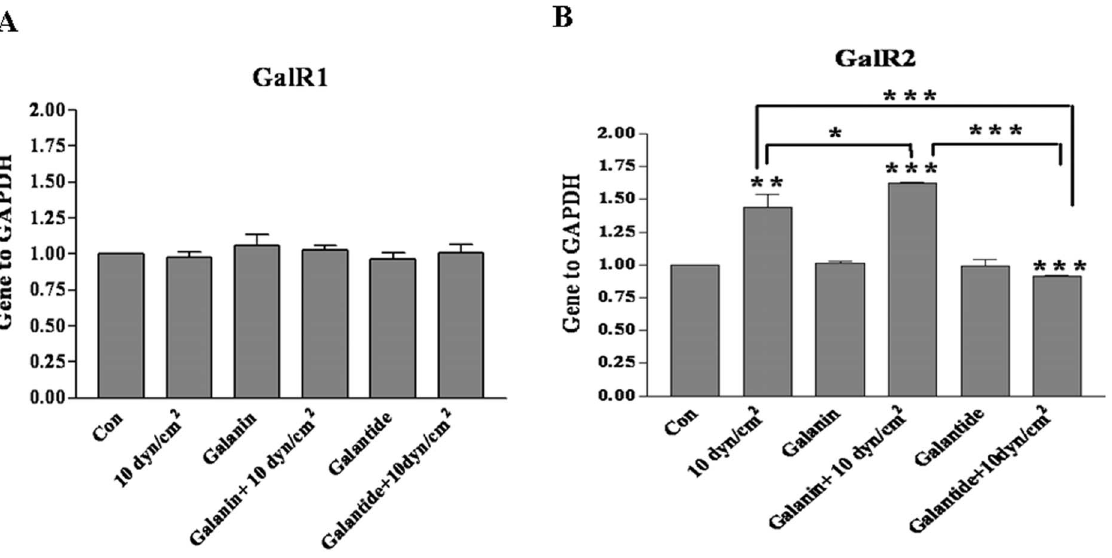
Figure 5. Expressions of mRNAs for GalR1, R2 and R3 after shear stress of 10 dyn/cm 2 for 12 h. (A) GalR1 mRNA levels in cultured cortical neurons after shear stress of 10 dyn/cm 2 for 12 h with galanin or galantide treatment was assessed by real time PCR assay. (B) GalR2 mRNA levels in cultured cortical neurons after shear stress of 10 dyn/cm 2 for 12 h with galanin or galantide treatment was assessed by real time PCR assay. GalR3 is not expressed in our system. The data are presented as mean 6 SD (n=3). * p , 0.05, ** p , 0.01 and *** p , 0.001 were considered to be statistically significant.